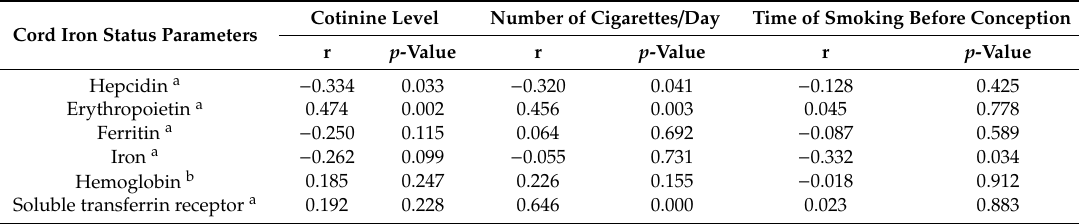
Table 3. Simple correlations between iron status parameters in the cord blood of newborns and markers for determining the intensity of mother’s smoking ( n = 40).